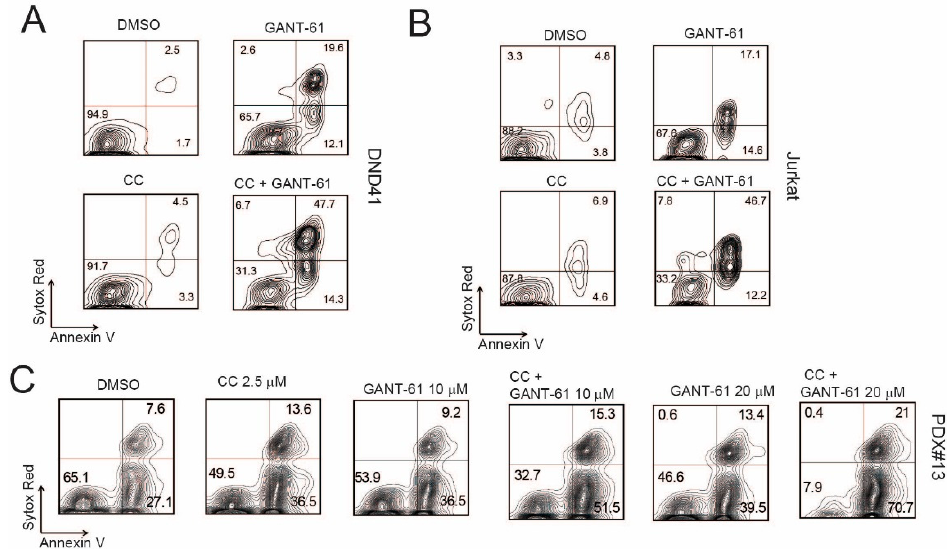
Figure 5. Pharmacological inhibition of AMPK increases the cytotoxic effects of GANT-61 in T-ALL cells. ( A , B ) Representative plots of apoptosis in DND41 ( A ) or Jurkat ( B ) T-ALL cells treated in vitro for 48 h with DMSO (vehicle), Compound C (CC) only (2.5 µM), GANT-61 only (20 µM), or CC + GANT-61. ( C ) Representative plots of apoptosis in patient-derived xenograft (PDX#13) T-ALL cells